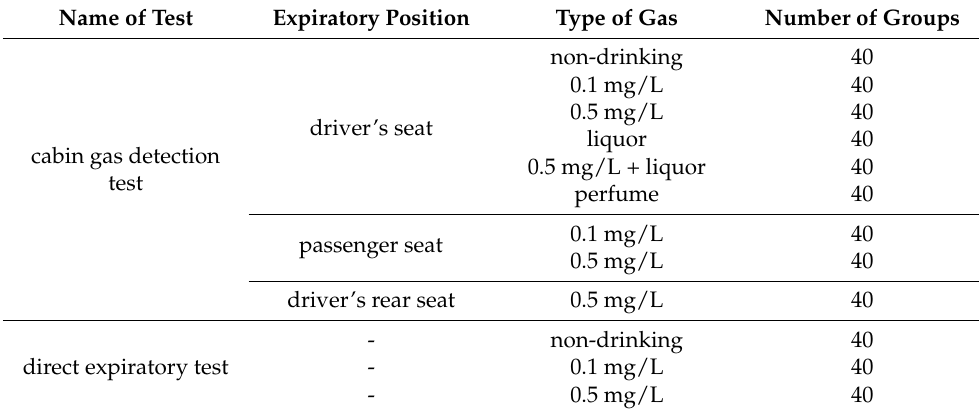
Table 2. Test groups designed according to the test